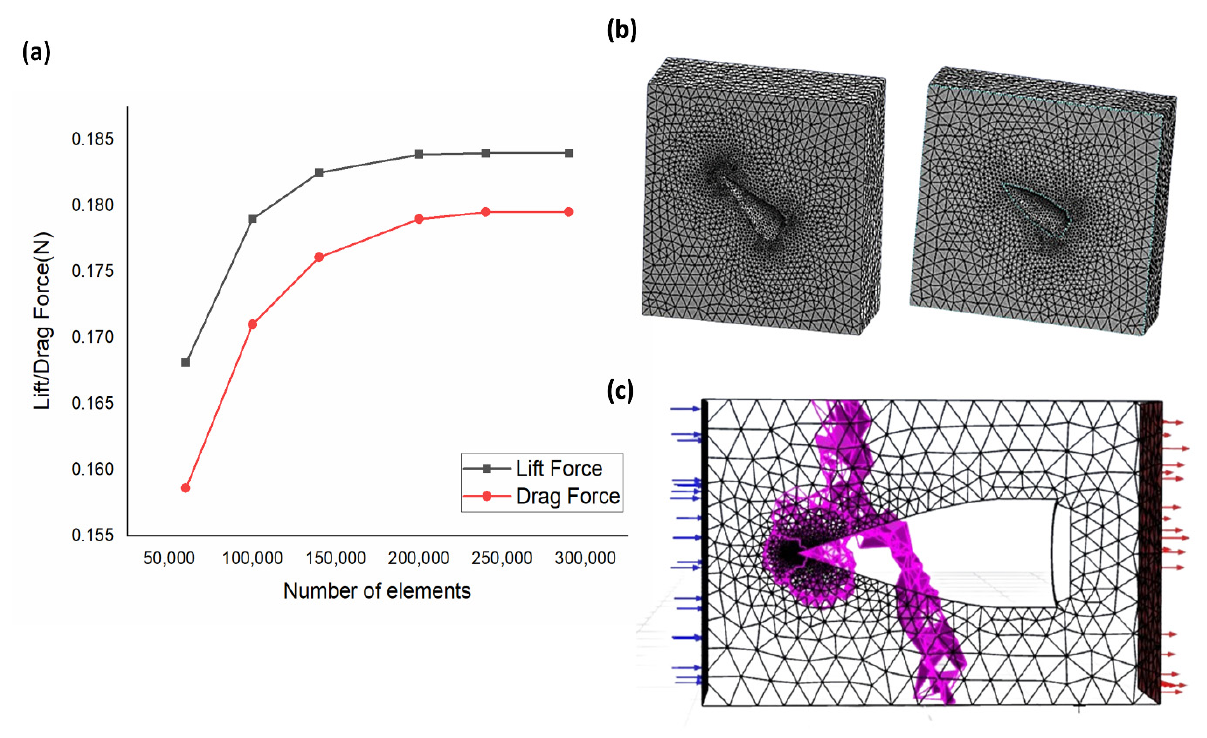
Figure 6. ( a ) Mesh independence test for lift and drag; ( b ) mesh diagrams of design I and design II the bullet head; ( c ) computational of the bullet head; ( c ) computational domain .